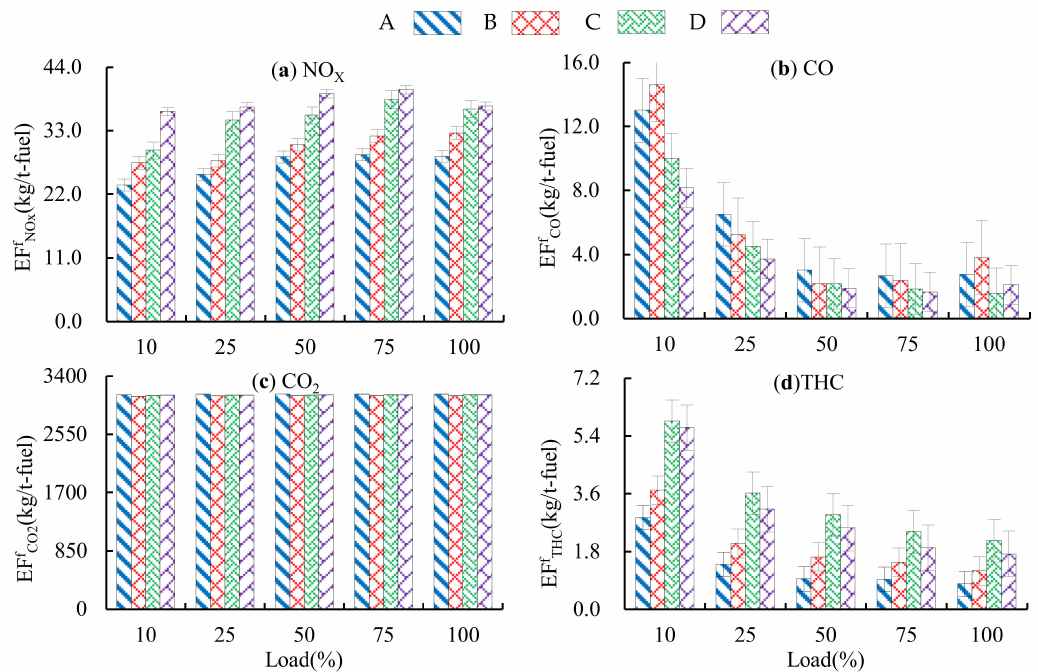
Figure 3. Relationship of fuel-based emission factors against engine load for AE. Fuel-based emission factors at five load points for the auxiliary engine. ( a ) NO X fuel-based emission factors, ( b ) CO fuel-based emission factors, ( c ) CO 2 fuel-based emission factors, and ( d ) THC fuel-based emission factors. The auxiliary engine works at a constant